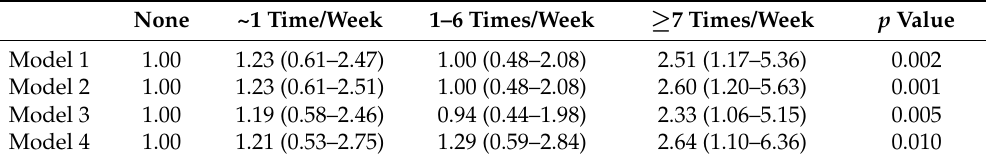
Table 2. Odds ratio (95% CI) for asthma by soft drink consumption levels 1